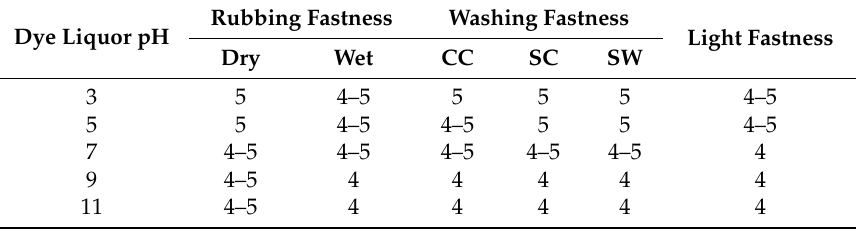
Table 5. The color fastness of dyed silk fabrics under the conditions of different acidity and alkalinity. Rubbing Fastness Washing Fastness Dye Liquor pH